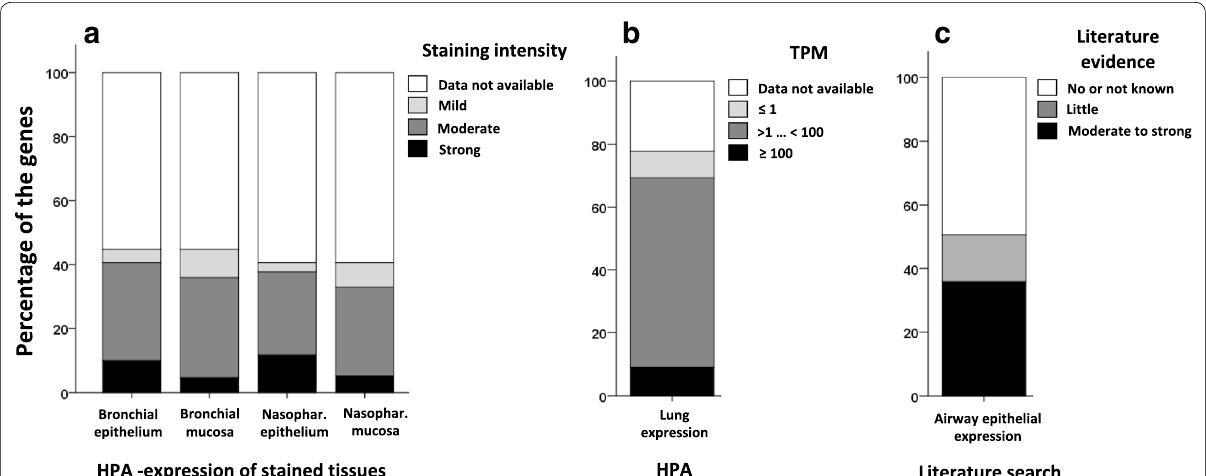
Fig. 3 Database and literature analysis of airway expression of the corresponding proteins of the protein coding GWAS‑level genes (n associating with asthma/AR. a Human protein Atlas (HPA) was used to search for photomicrographs of the proteins and their staining intensity was semi‑quantitatively evaluated by two observers. b HPA results of lung expression in Transcripts per million (TPM). c Literature search results of airway epithelial expression of these genes. Pubmed search was performed by using search terms “(Gene name OR alias) AND epitheli* AND airway/ bronc*”, Nasophar =